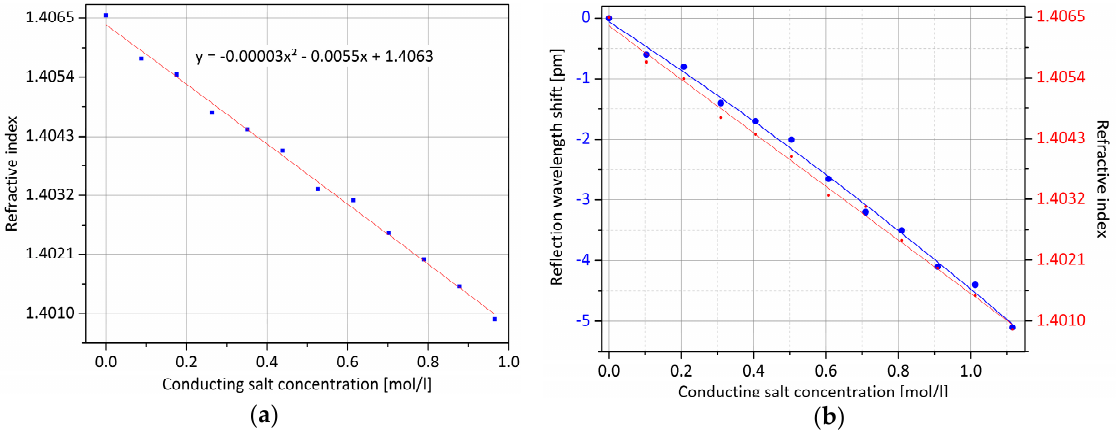
Figure 9. Change in the refractive index of a standard electrolyte of a lithium ion battery cell with increasing conducting salt concentrations: ( a ) Using a refractometer, the value curve was measured and approximated in a quadratic equation; ( b ) The red curve corresponds to the one from (a), whereby the indicated values are extrapolated according to the optical measured values symbolized by the blue curve. Through relative measurement with the surface Bragg grating, mainly identical concentration values are determined.